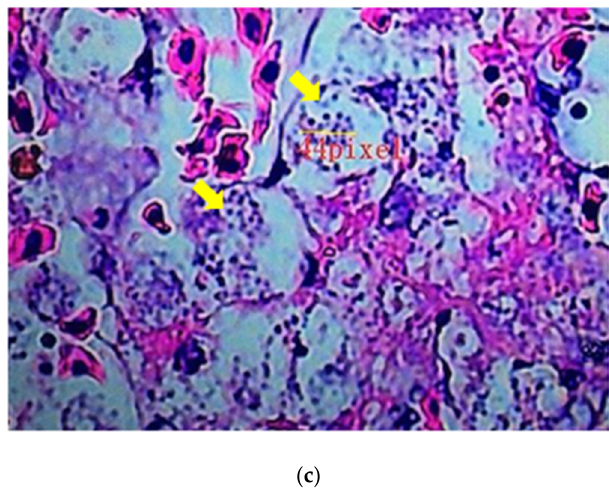
Figure 4. Histopathological sections of spleen tissues of dead fish from the experimental challenge group. ( a ) Spleen shows multifocal necrosis (black arrows). ( b ) A loosely formed, vacuolated granuloma typical of francisellosis observed in the spleen (red arrow). ( c ) At high magnification, bacterial cells are observed in the necrotic area inside vacuoles (yellow arrows) (H&E Stain).